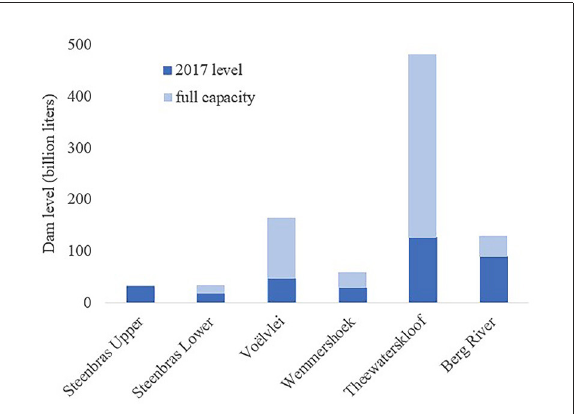
FIGURE2 Total capacities (light blue) and 2017 levels (dark blue) of the Big Six dams that supply Cape Town, South Africa.